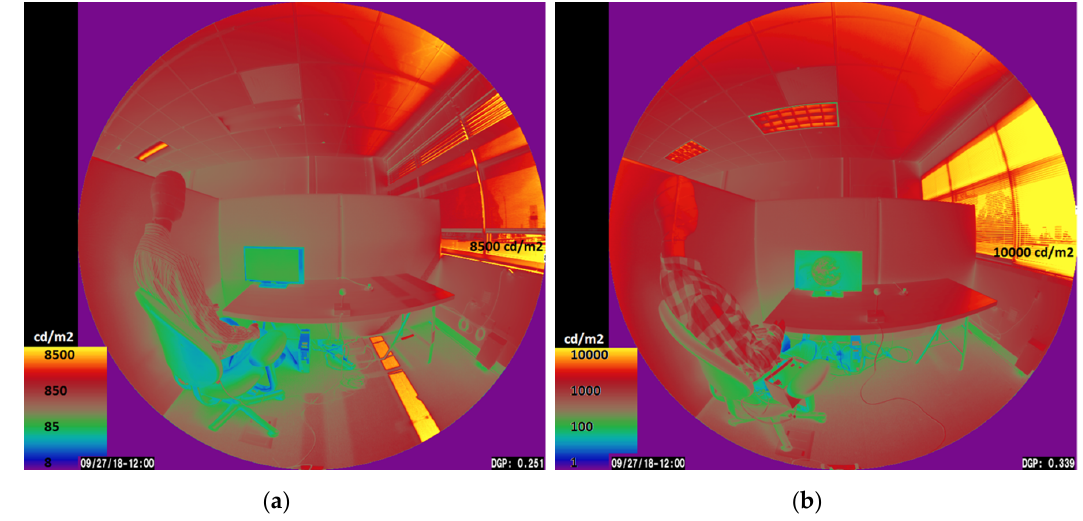
Figure 7. False color images from the HDR cameras and processors show luminance distributions in the space and calculated DGP, for: ( a ) the retrofit test cell, and ( b ) the baseline test cell.